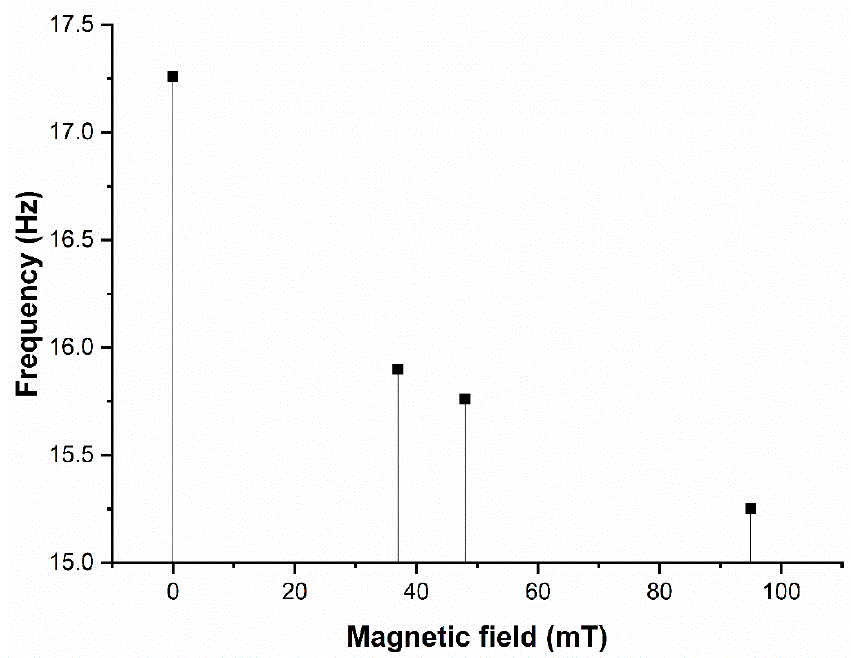
Figure 9. Experimental natural frequency at different magnetic field regions.